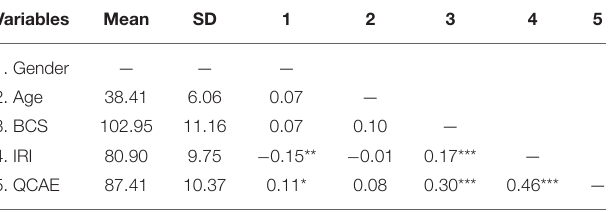
TABLE 1 | Means, SDs, and correlation matrix among the variables in study 1.